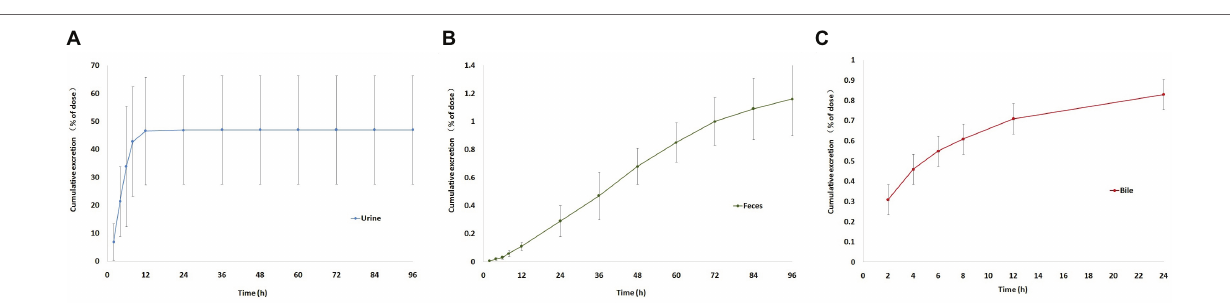
FIGURE 10 | Cumulative excretion of sodium danshensu in rat after intravenous administration of 30 mg/kg. (A) Cumulative excretion of sodium danshensu in rat urine. (B) Cumulative excretion of sodium danshensu in rat feces. (C) Cumulative excretion of sodium danshensu in rat